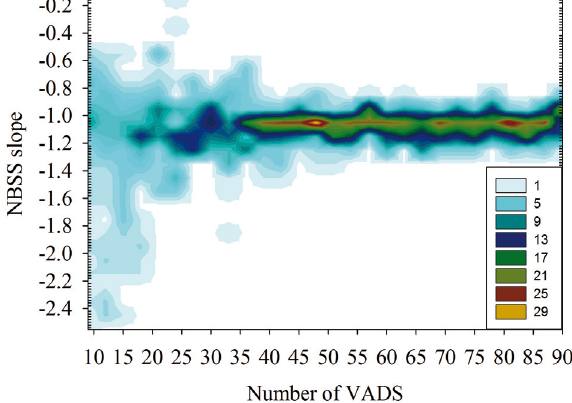
F ig . 2. – Behaviour of the slope b of the normalized biomass size spectrum (NBSS) of the dynamic approach when the number of virtual allometrically derived species (VADS) considered in the simulations is increased. The color scale indicates how many food webs have the same NBSS